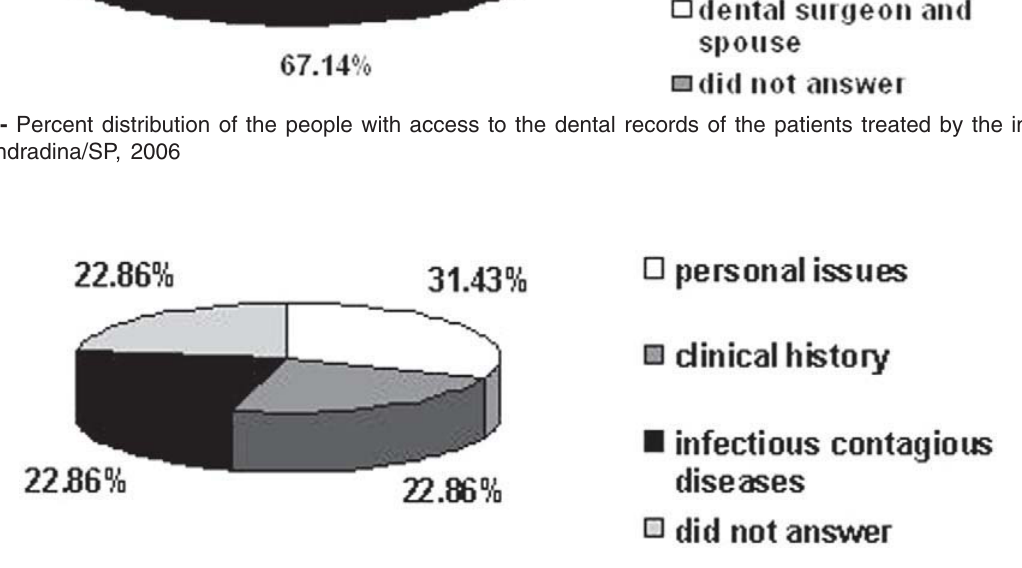
FIGURE 3- Percent distribution of the dentists according to the type of information they consider breach of confidentiality. Andradina/SP, 2006